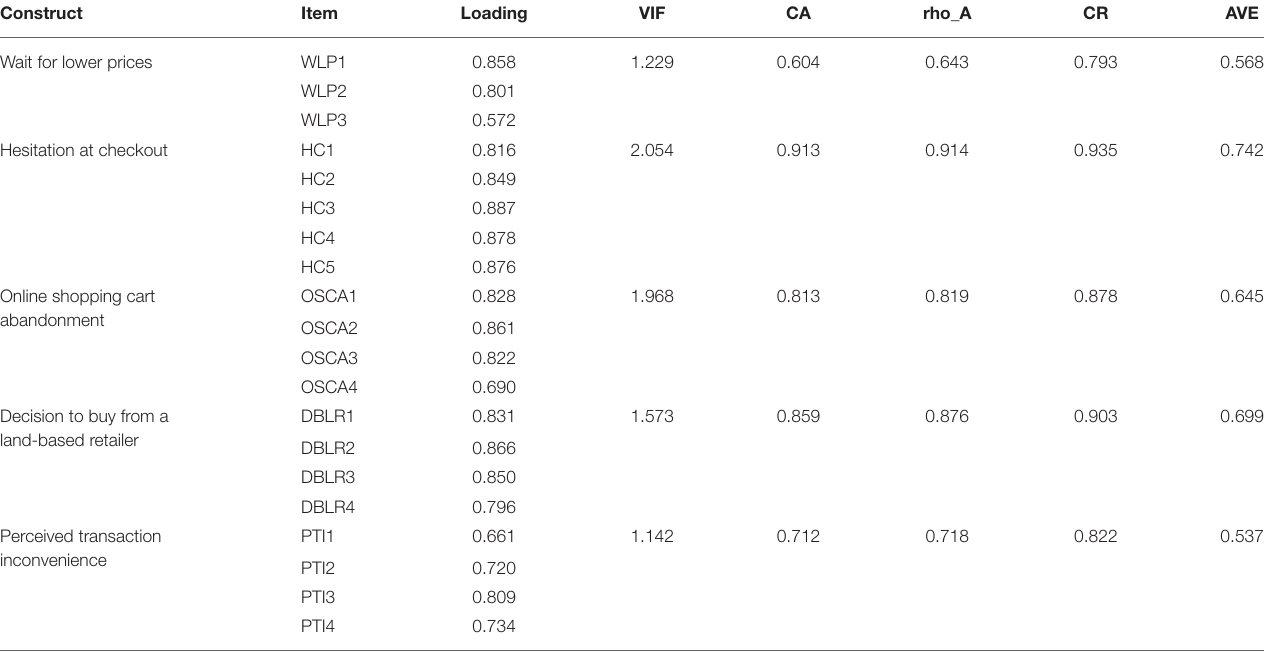
TABLE 2 | Results of the measurement model. Construct